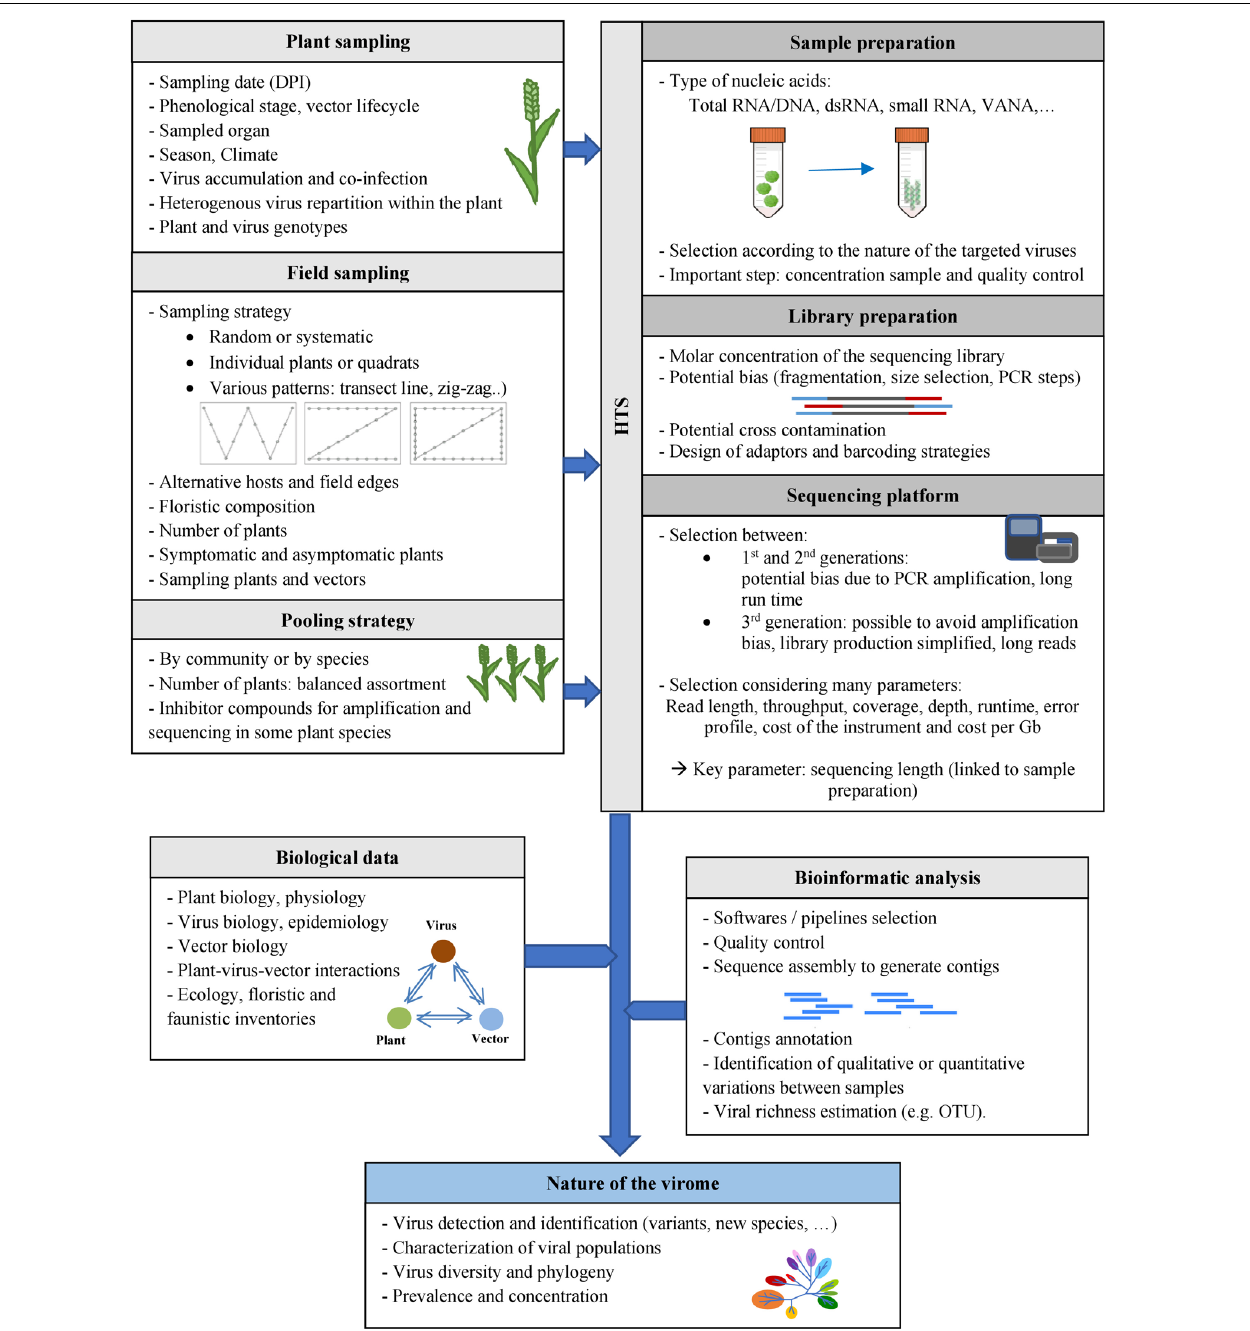
FIGURE 2 | Methods for characterizing the viromes of plant communities. Various factors may potentially impact HTS-based viral ecology studies, at the different steps of these studies: plant sampling at days post-infection (DPI), field sampling, pooling strategies, sample and library preparation methods, selection of the sequencing platforms and bioinformatic analyses. Biological data on the viruses, their host plants and vectors (if known) could also be useful for viral ecology